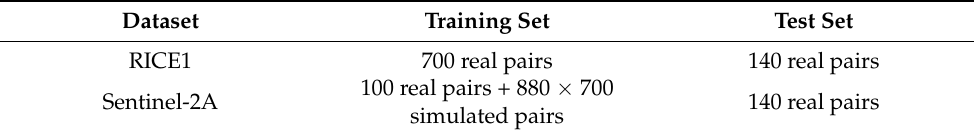
Table 2. The composition of the RICE1 and Sentinel-2A datasets used in